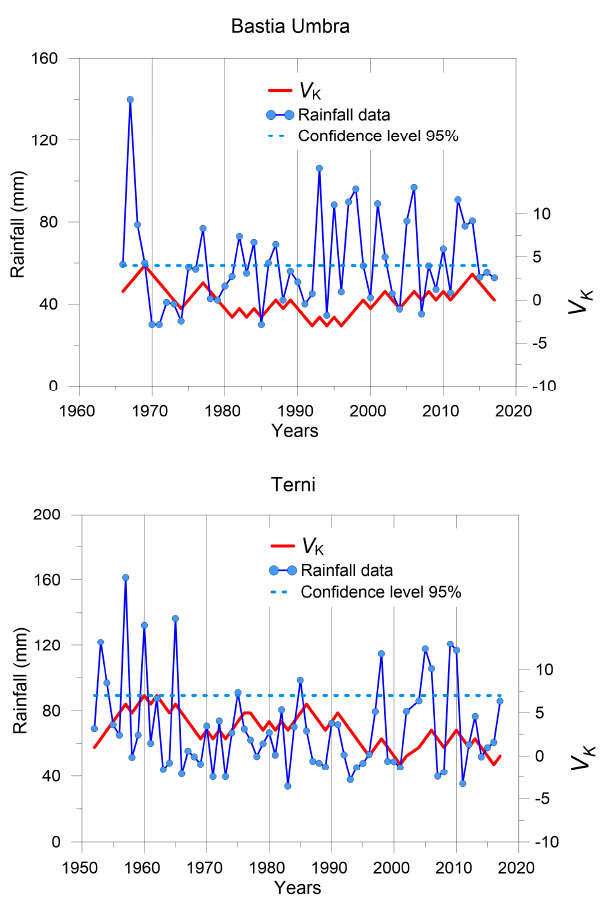
Figure 4. Results obtained at the Bastia Umbra and Terni stations after applying the CUSUM test.